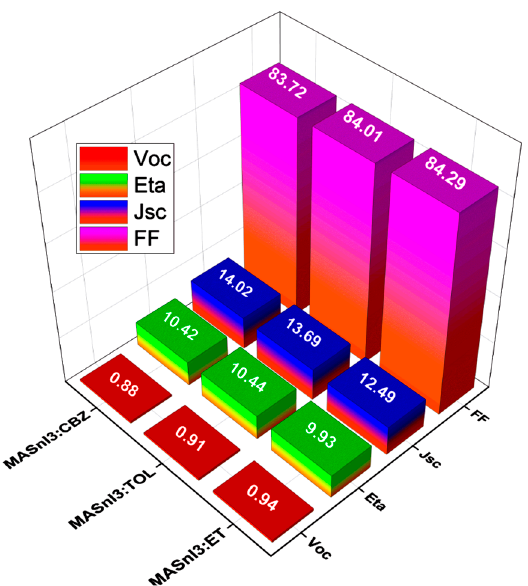
Figure 7. Characteristic parameters of a MASnI 3 -based solar cell when using the different antisolvents.